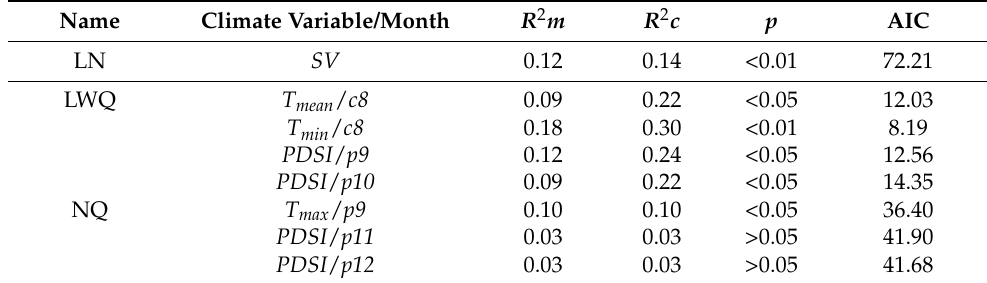
Table 3. Summary of the linear mixed-effects models (LMMs) fitted to shrub ring-width indices at the two sites. Abbreviations: LWQ + NQ (LN), LMM model for the mixed data of two sites; T mean , mean temperature; T min , mean minimum temperature; T max , mean maximum temperature; PDSI , Palmer Drought Severity Index; c8 ( c9 ), current August (September); p9 ( p10 , etc.), previous September (October etc.); SV , seven variables ( PDSI in previous September to December, mean and minimum temperature in current August, maximum temperature in previous September); R 2 m , marginal R 2 ; R 2 c , conditional R 2 ; AIC, Akaike Information